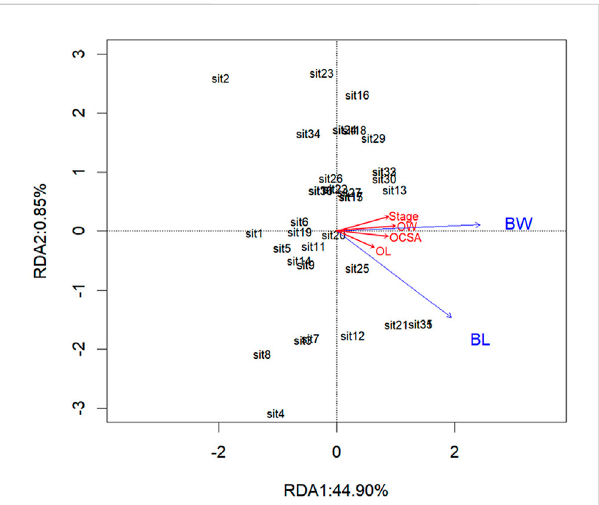
FIGURE 6 Redundancy analysis diagram of correlations between independent variables and the ovarian developmental parameters. The ovarian developmental parameters are indicated by red color arrows: OL, ovarian length; OW, ovarian width; OCSA, ovarian cross-sectional area. The independent variables are indicated by blue color arrows: BL, body length; BW, body weight.